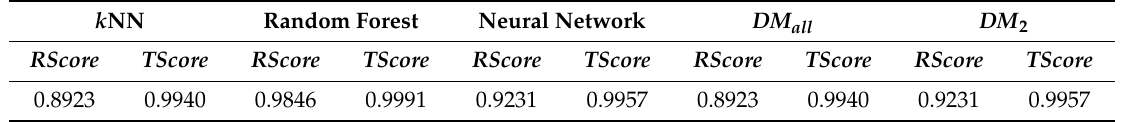
Table 6. The accuracy of the initial risk detection model for the initial training data. k NN: k Nearest Neighbors. k NN